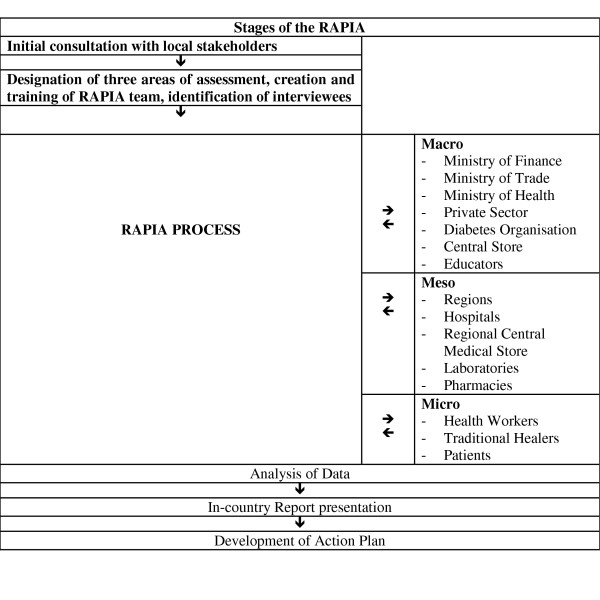
Stages of the RAPIA.